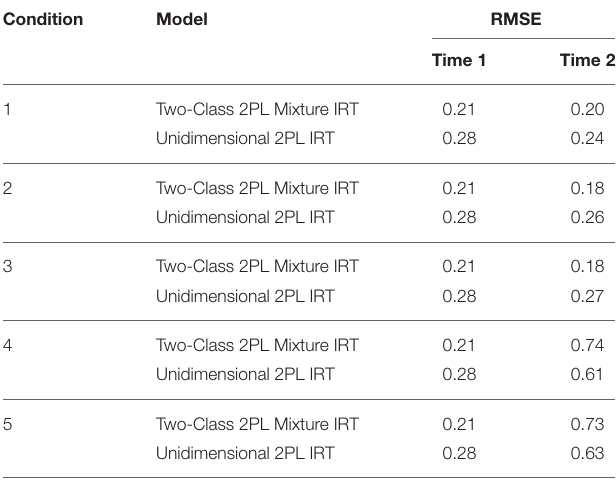
TABLE 11 | Changes in the root mean squared error (RMSE) of ability estimates using population and estimated